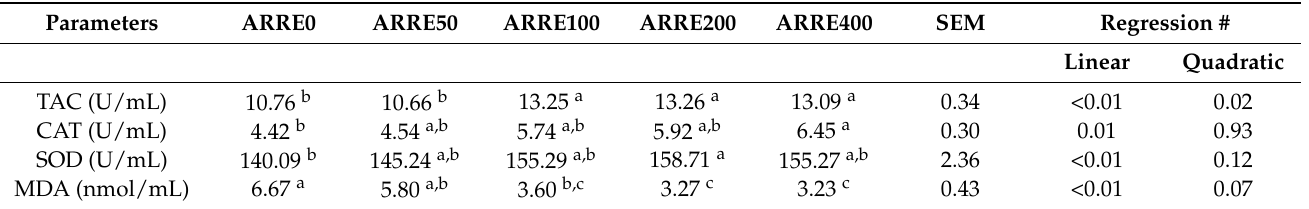
Table 9. The effect of dietary supplementation of ARRE on the serum antioxidant activity of broiler chickens.